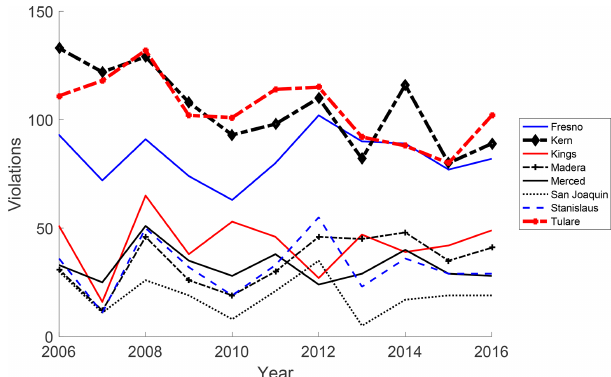
Figure 4. Tulare and Kern counties show signs of a downward trend for ozone MDA8 violations, while the other counties of the SJV, which are largely rural, do not. Data provided by California Air Resources